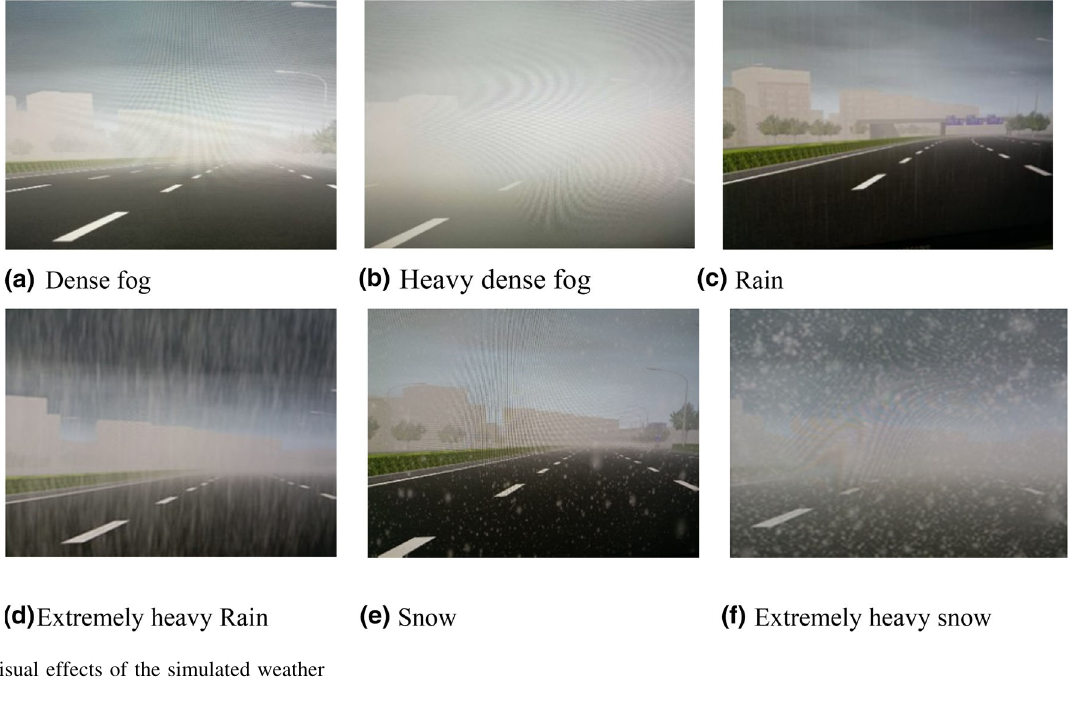
Fig. 3 Visual effects of the simulated weather